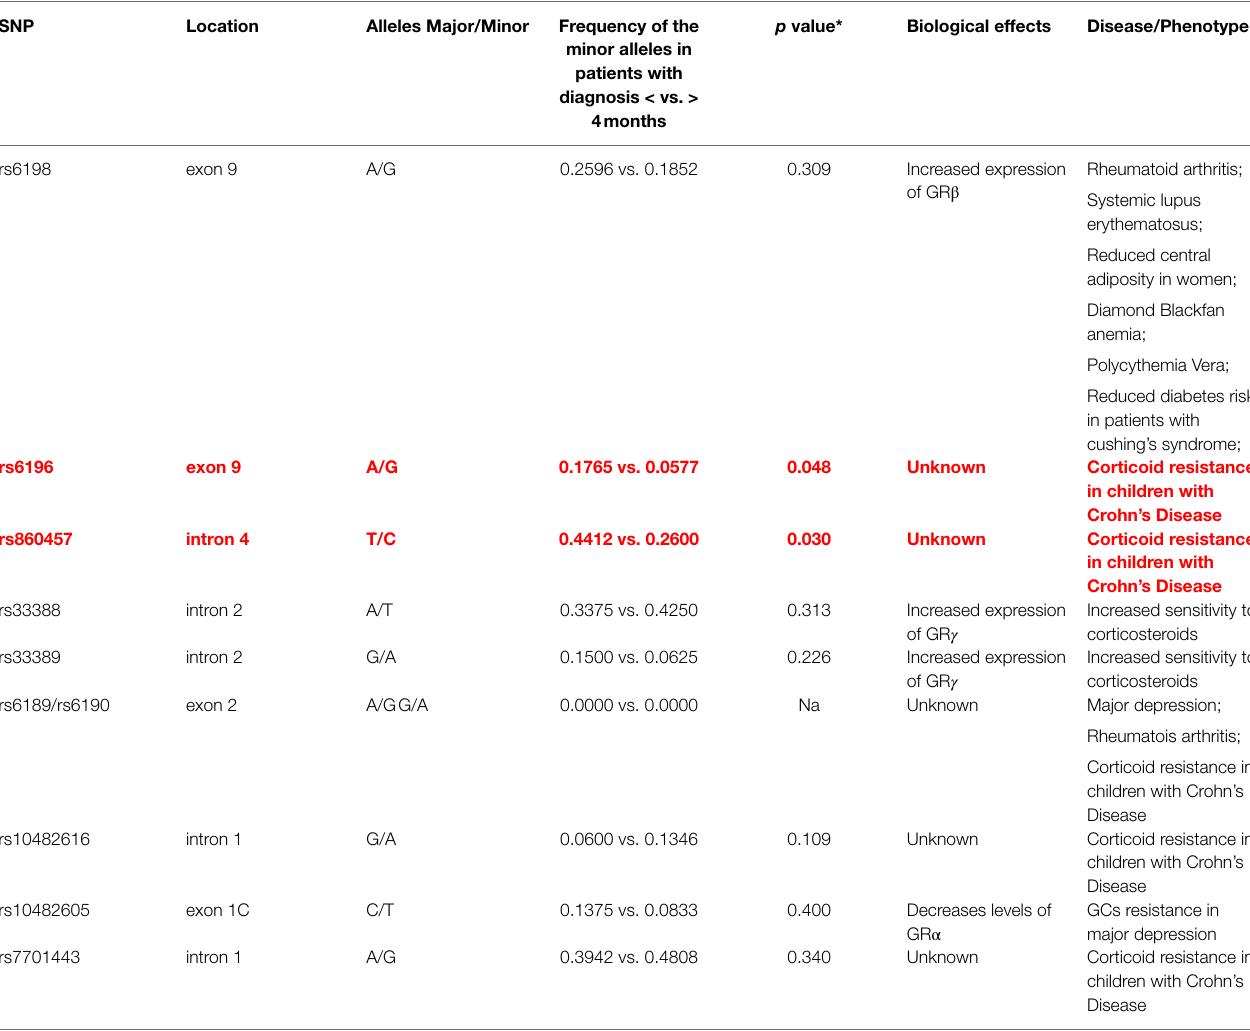
TABLE 6 | Summary of the SNPs investigated, of their association with diagnosis at 4 months in DBA, of their published biological effects and of their association with other diseases.